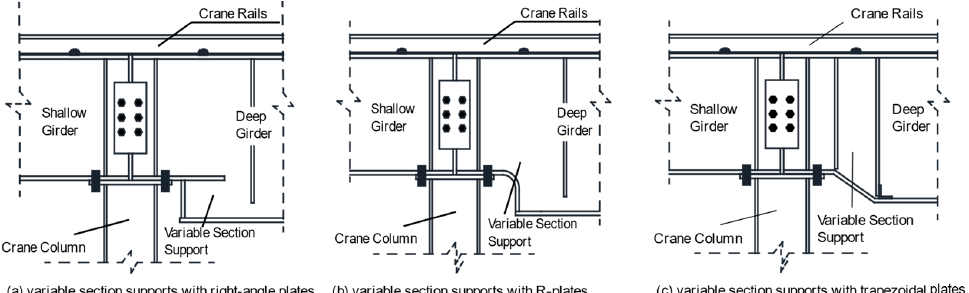
Figure 2. Three variable-section